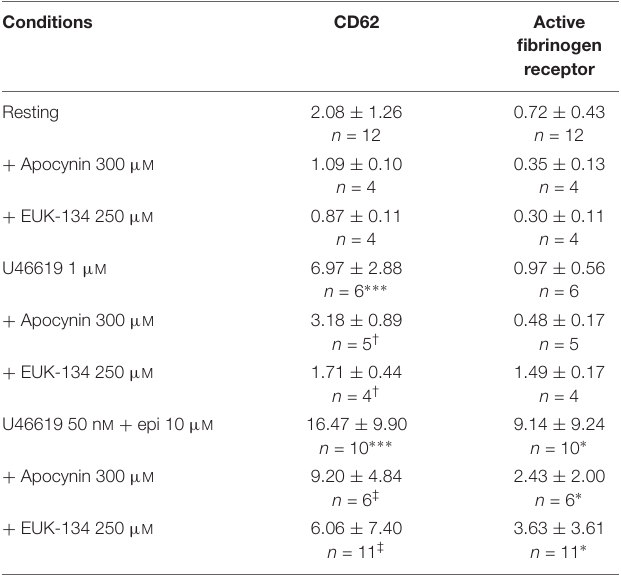
TABLE 6 | Effect of the NADPH oxidase inhibitor apocynin 300 µ M and the ROS scavenger EUK-134 250 µ M on the expression of P-Selectin (CD62P) and of active form of fibrinogen receptor in washed platelets pre-treated with ASA 100 µ M and apyrase VII 10 U mL − 1 .